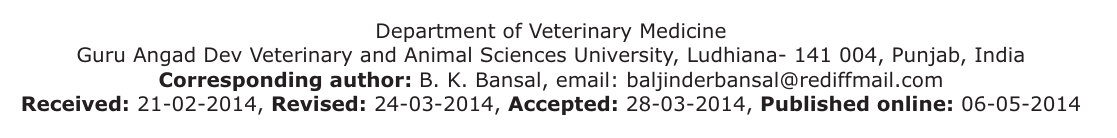
pattern at machine milking which has recently been introduced in Indian system is to be studied. Therefore the present